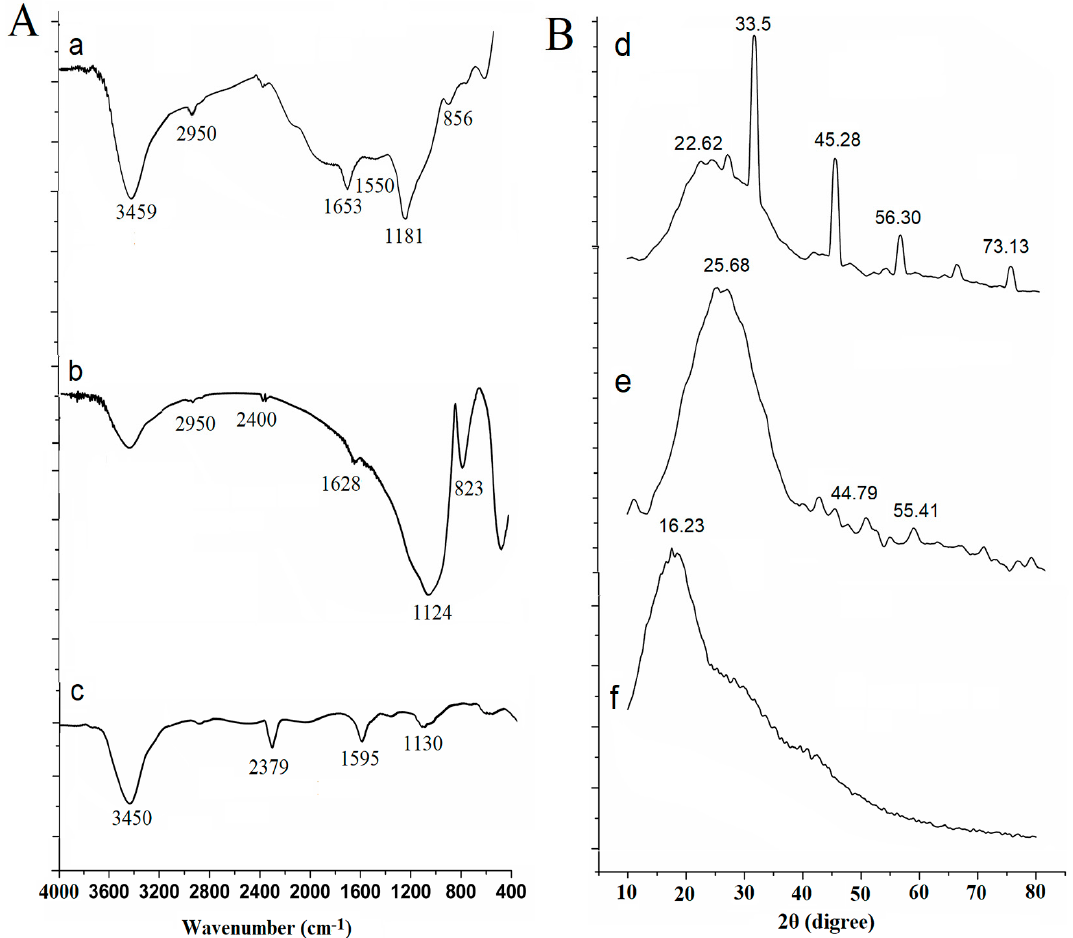
Figure 5. The FT-IR spectra ( A ) and X-ray diffraction patterns ( B ) of biofilms formed with LB medium and LB medium containing graphene nanomaterials (10 mg/L) in a microreactor by segment flow. Biofilm formed with LB medium ( a , d ); biofilm formed with LB medium containing graphene nanomaterials (10 mg/L) ( b , e ); graphene nanomaterials ( c , f ).